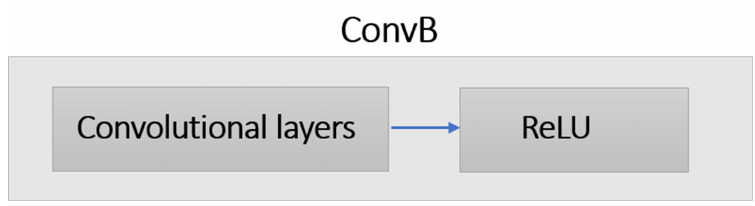
Figure 4. The detail of the layers in each convolutional block